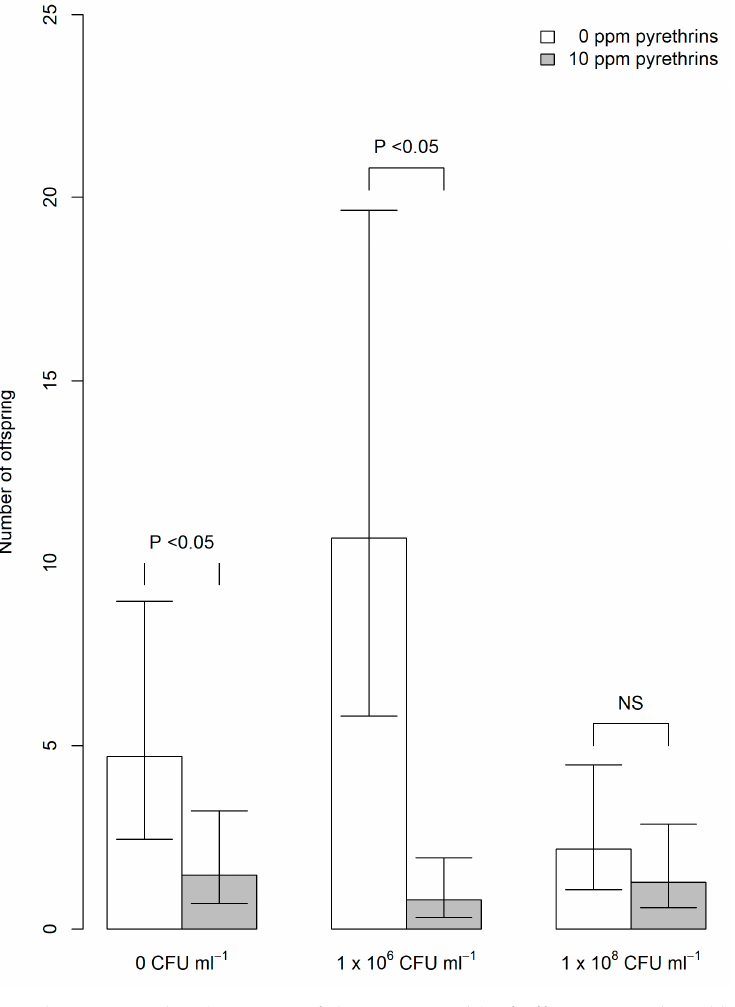
Figure 3. Predicted mean number (± 95% confidence intervals) of offspring produced by individual A. fabae exposed to M. anisopliae alone (white bars) or in combination with pyrethrum (10 ppm pyrethrins; grey bars). EPF was tested at 0 colony forming units (CFU) mL − 1 (carrier oil only, left), 1 × 10 6 CFU mL − 1 (middle) and 1 × 10 8 CFU mL − 1 (right).